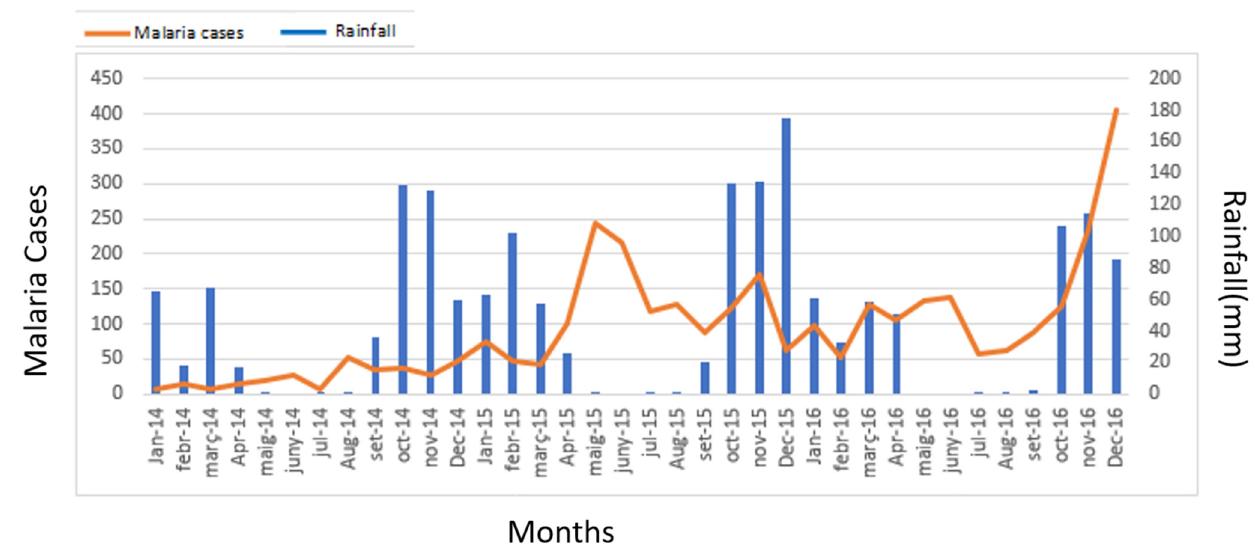
Figure 4. Absolute number of malaria cases (orange) and rainfall (blue columns) by month in Cubal, years 2014 and 2016.